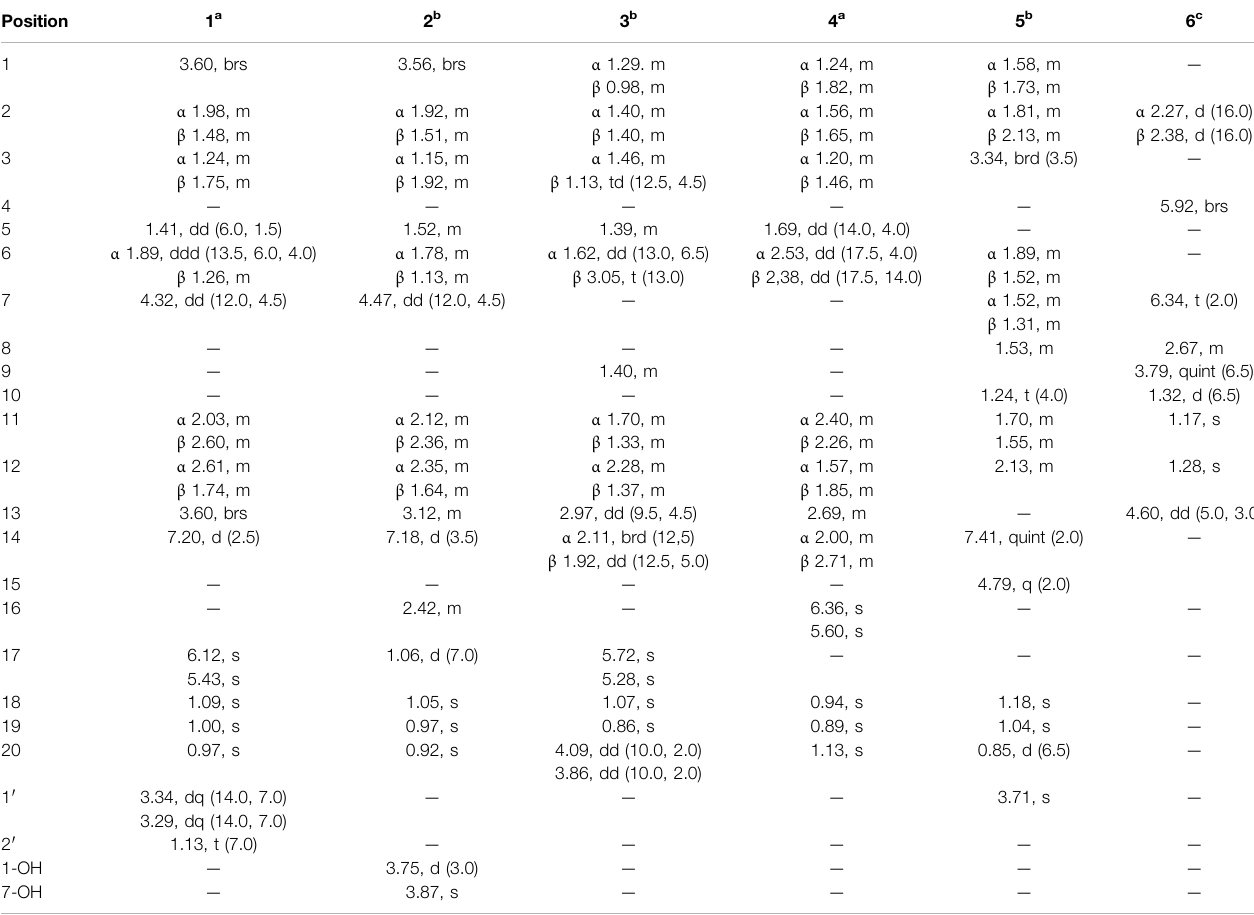
TABLE 1 | 1 H NMR (500 MHz) data of compounds 1 – 6 ( δ in ppm, J in Hz).